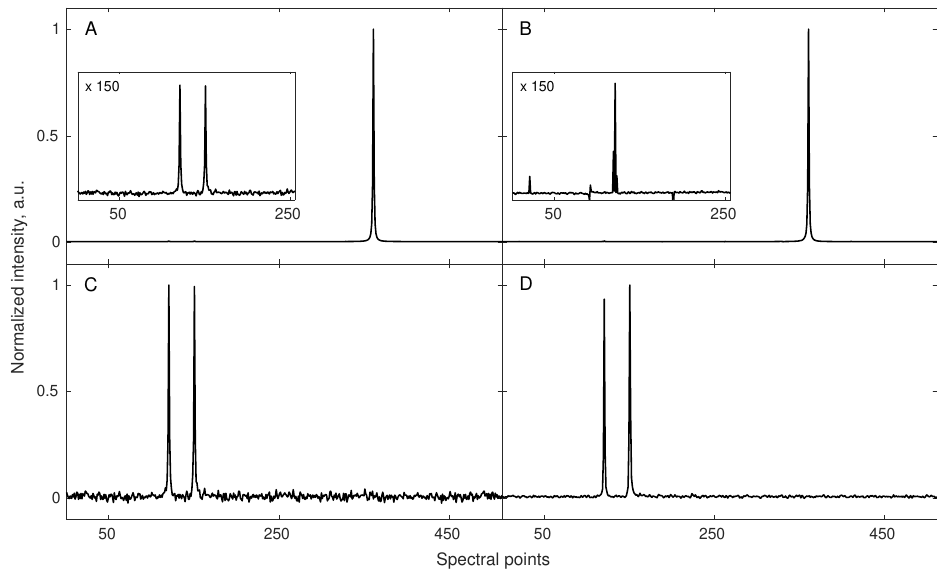
Figure 2. A simulation demonstrating the quality of the reconstruction of a signal built of two low amplitude components and one very high amplitude component ( A , B ); and of the reconstruction of the same signal with the highest amplitude component being removed ( C , D ). Both starting signals (their corresponding spectra— A , C ) were sub-sampled to the same 42 random points (out of 512 points) and reconstructed using 40 iterations of the IRLS algorithm. The reconstruction of low amplitude signals in the presence of a high dynamic range of amplitudes was unsuccessful ( B ). The same sub-sampling level and scheme turned out to be sufficient for the fine reconstruction of the signal in the absence of a high amplitude component ( D ). The ratio of the largest peak intensity to the small ones in ( A ) was 160. Notably, the level of noise, artificially added to the FID is not reproduced in the CS